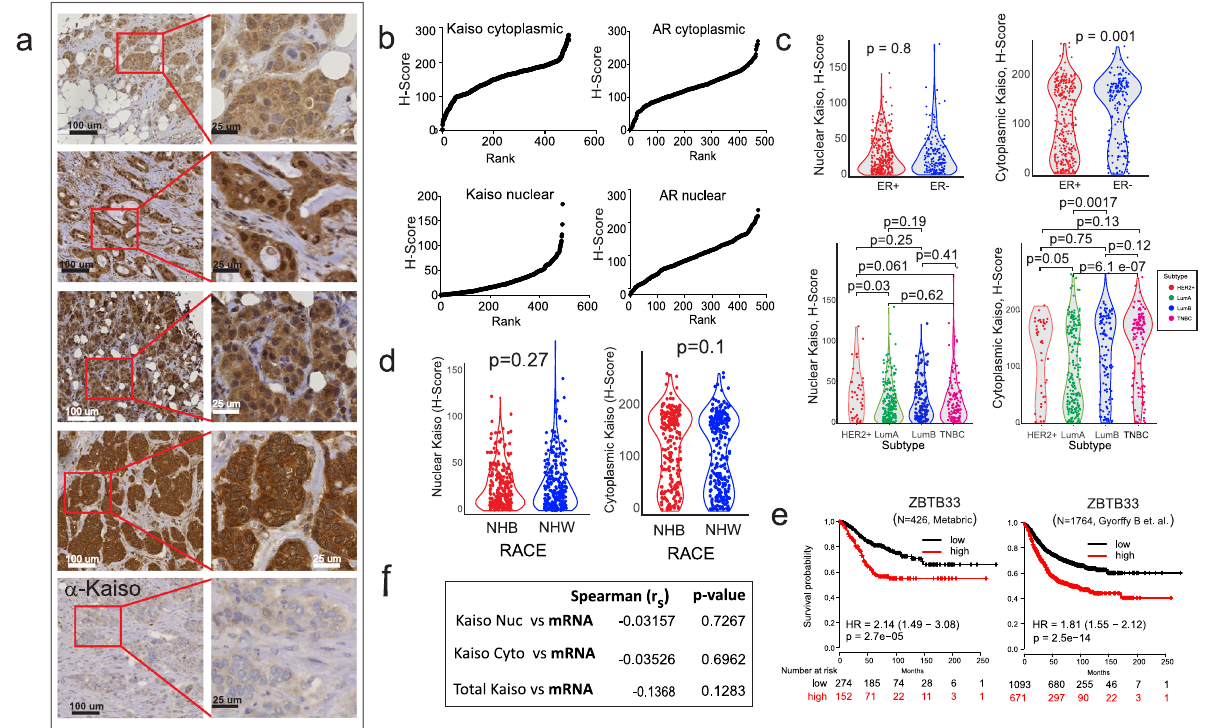
Fig. 1 Pro fi les of the subcellular distribution of Kaiso ( ZBTB33 ) show that nuclear and cytoplasmic Kaiso are differentially correlated with breast cancer subtype and hormone status. a Representative subcellular patterns of Kaiso expression in breast cancer tissues detected by anti -Kaiso immunohistochemical staining. Shown is a range of high (upper panels) versus low (bottom panel) nuclear and cytoplasmic protein expression. b Comparison of the distribution of digitally determined H-scores for nuclear versus cytoplasmic Kaiso enrichment. The difference in distribution is shown in contrast to the similarities in the distribution of nuclear versus cytoplasmic androgen receptor (AR). c Cytoplasmic Kaiso is differentially enriched in ER − breast cancers compared to nuclear Kaiso and is signi fi cantly enriched in the more aggressive breast cancer subtypes, LumB, HER2 + , and TNBC. d Nuclear and cytoplasmic levels of Kaiso ( H -score) do not show signi fi cant differences ( t -test) based on race (also see Supplementary Fig. 1). e Kaiso ( ZBTB33 ) mRNA abundance (median) is predictive of poor overall breast cancer survival as demonstrated in two independent publicly available breast cancer cohorts 88 . f Comparison of nuclear and cytoplasmic levels of Kaiso in breast cancer patients to levels detected by RNA-seq in ( N = 131) patients demonstrates that Kaiso ( ZBTB33 ) mRNA levels do not correlate with either nuclear or cytoplasmic levels of Kaiso. LumA Luminal A, LumB Luminal B, HER2 + human epidermal growth factor receptor 2 positive, TNBC triple-negative BC, ER estrogen-receptor status, NHW non-Hispanic White, NHB non- Hispanic